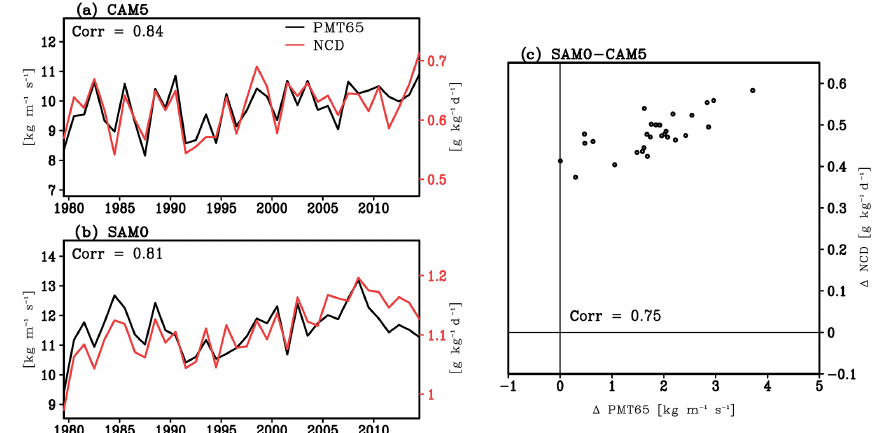
Figure 7. Interannual time series of the vertically integrated annual-mean poleward moisture flux at 65 ◦ N (PMT65, black line) and net condensation rate of water vapor into cloud liquid (NCD, red line) averaged over the Arctic from (a) CAM5 and (b) SAM0, and (c) scatter plot of the differences in annual-mean PMT65 and NCD between SAM0 and CAM5.